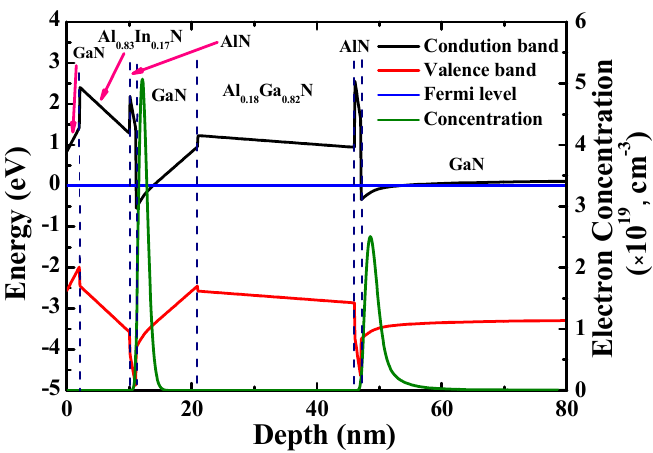
Figure 2. Simulated band diagram and electron concentration distribution in epitaxial layers.